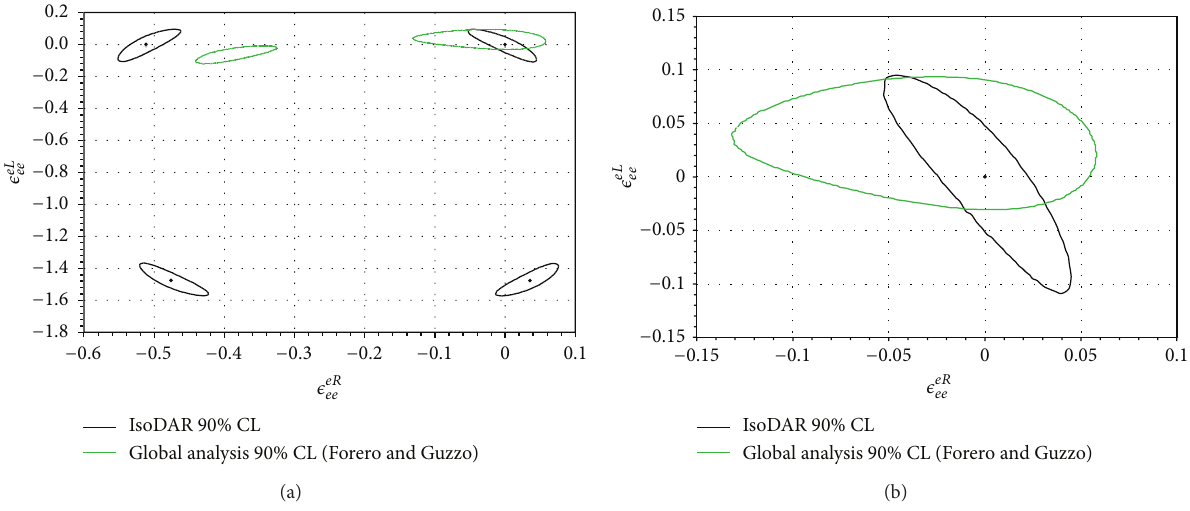
Figure 10: (a) IsoDAR’s sensitivity to 𝜖 𝑒𝐿 𝑒𝑒 and 𝜖 𝑒𝑅 𝑒𝑒 . The current global allowed region, based on [24], is also shown. (b) A zoomed-in version of the top plot, emphasizing the region near 𝜖 𝑒𝐿 𝑒𝑒 and 𝜖 𝑒𝑅 𝑒𝑒 ∼ 0 , is shown.